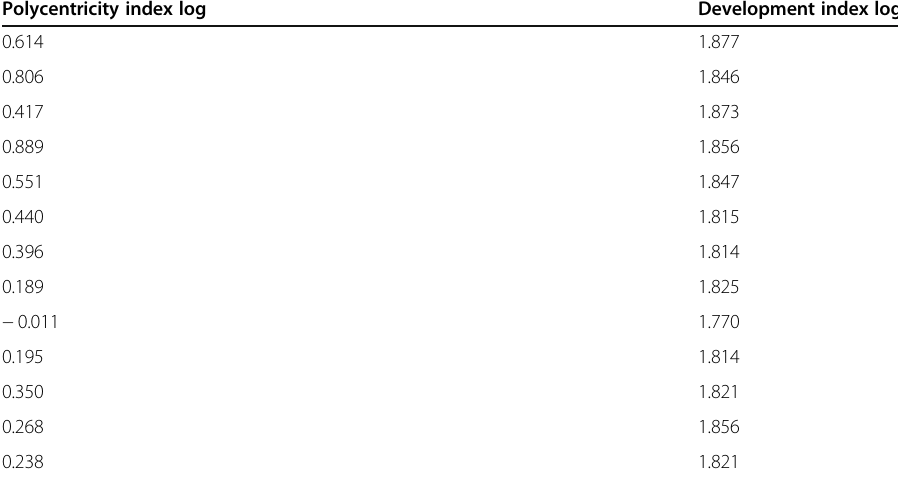
Table 4 Polycentricity index values and normalized development index values for 13 European countries